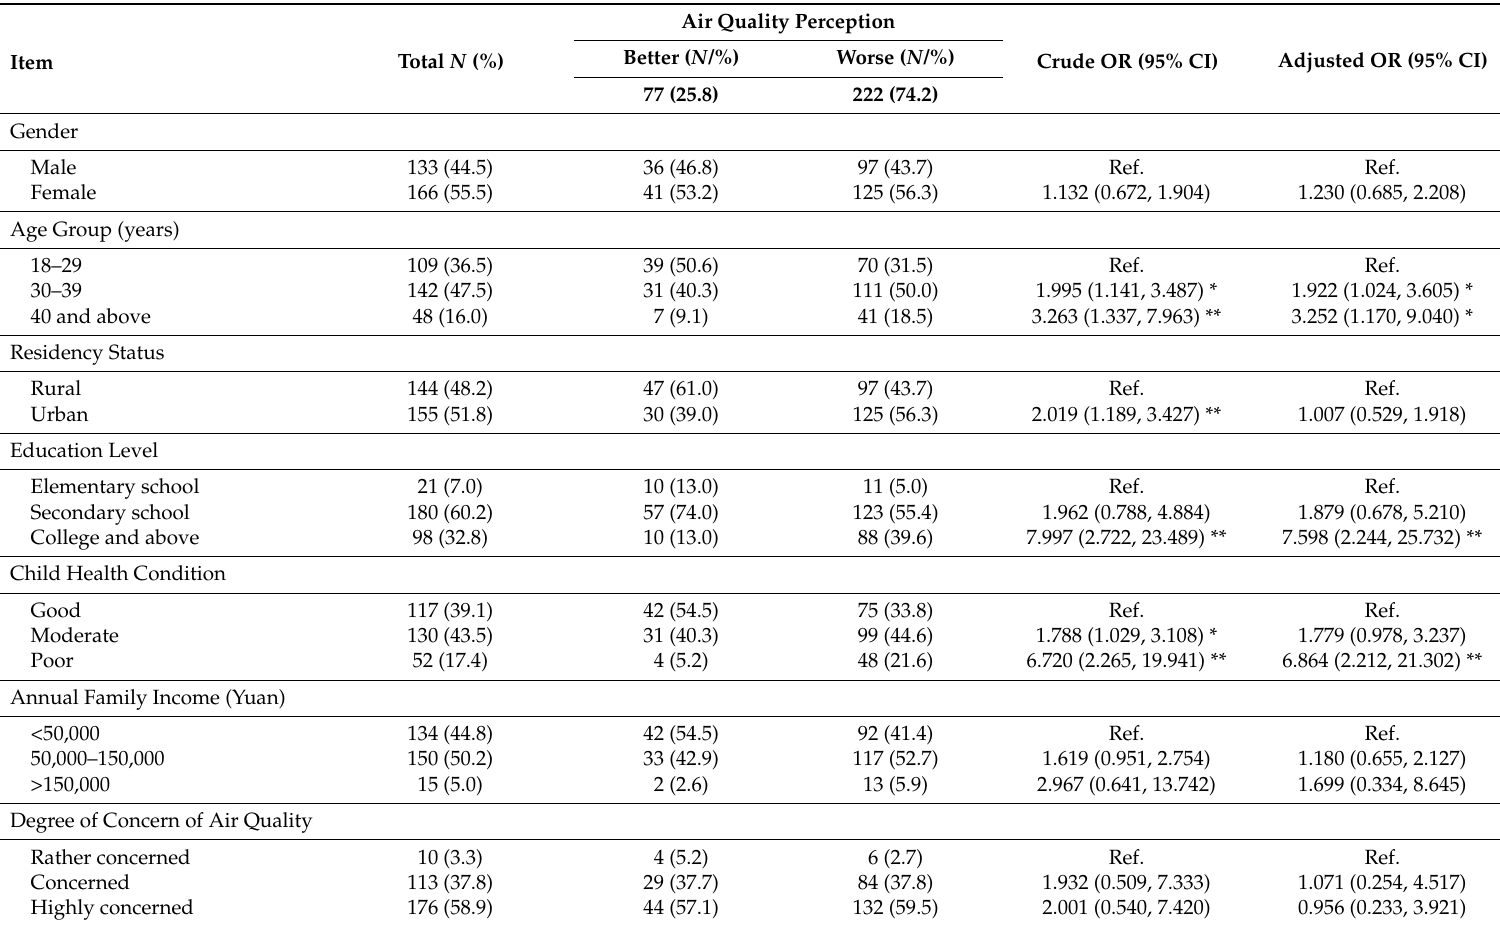
Table 3. Logistic regression analysis (OR and 95% CI) for air quality perception: at the individual level of the hospital